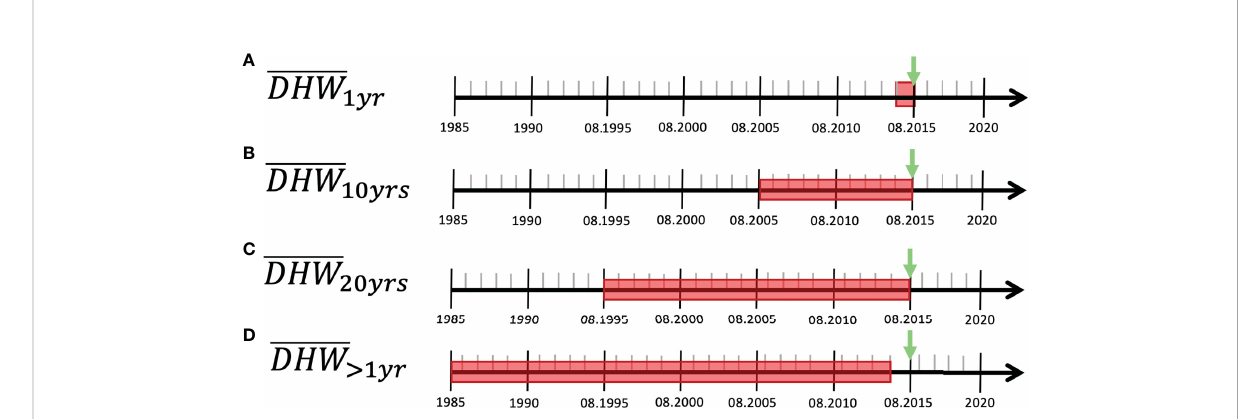
FIGURE 2 Degree heating week (DHW) periods. The fi gure summarizes the four temporal windows ( A : one year before sampling, B : 10 years before sampling, C : 20 years before sampling, D : all the years from 1985 to one year before sampling) across which three period-speci fi c DHW statistics (mean, standard deviation, maximal value) were calculated. The timelines are hypothetical examples, where the green arrows indicate a hypothetical date of the coral cover survey, and the red boxes show the periods of interest used to calculate period-speci fi c DHW